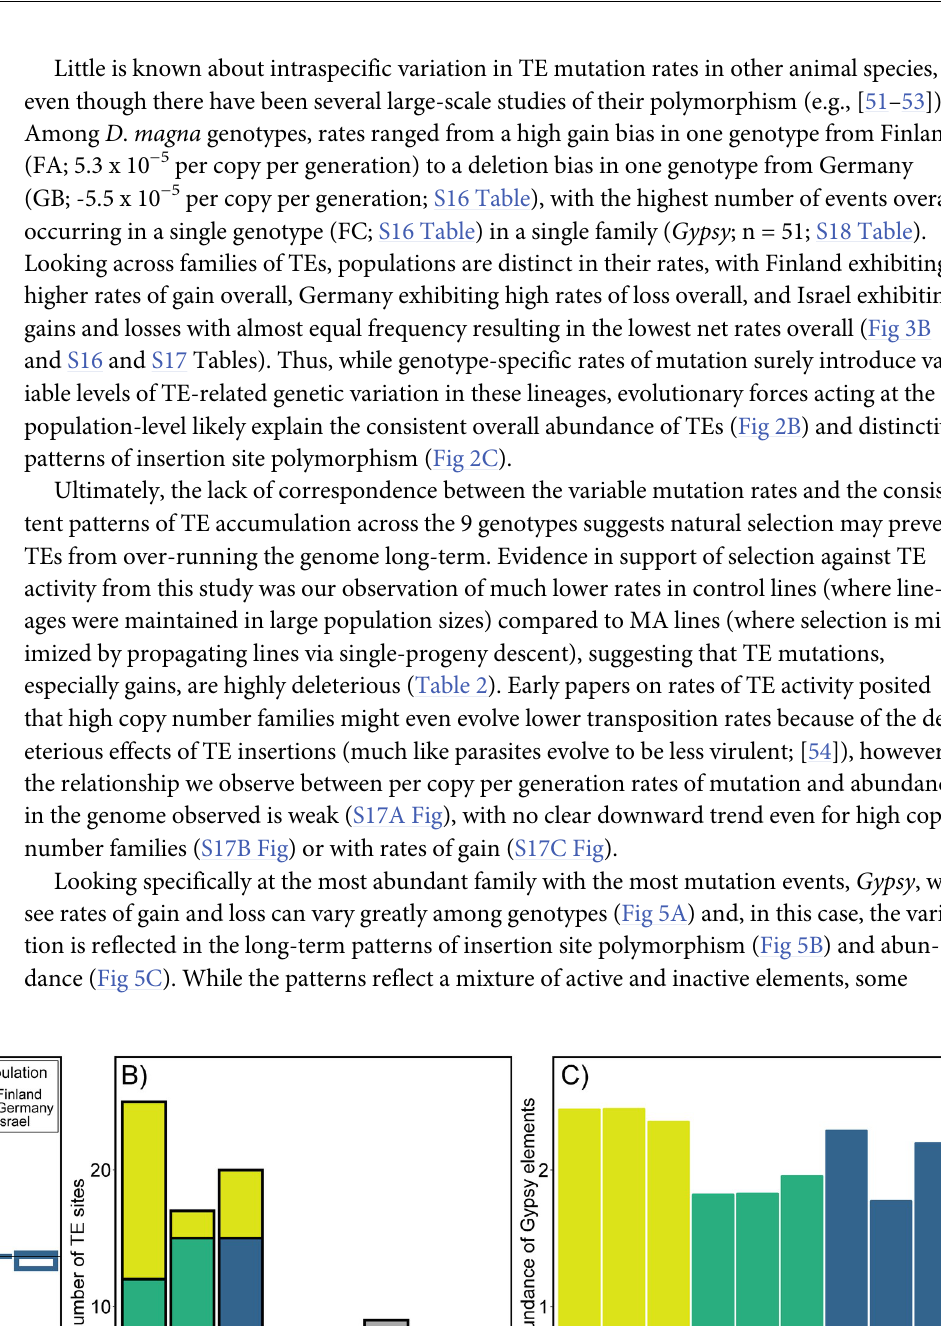
PLOS Genetics | https://doi.org/10.1371/journal.pgen.1009827 November 1,